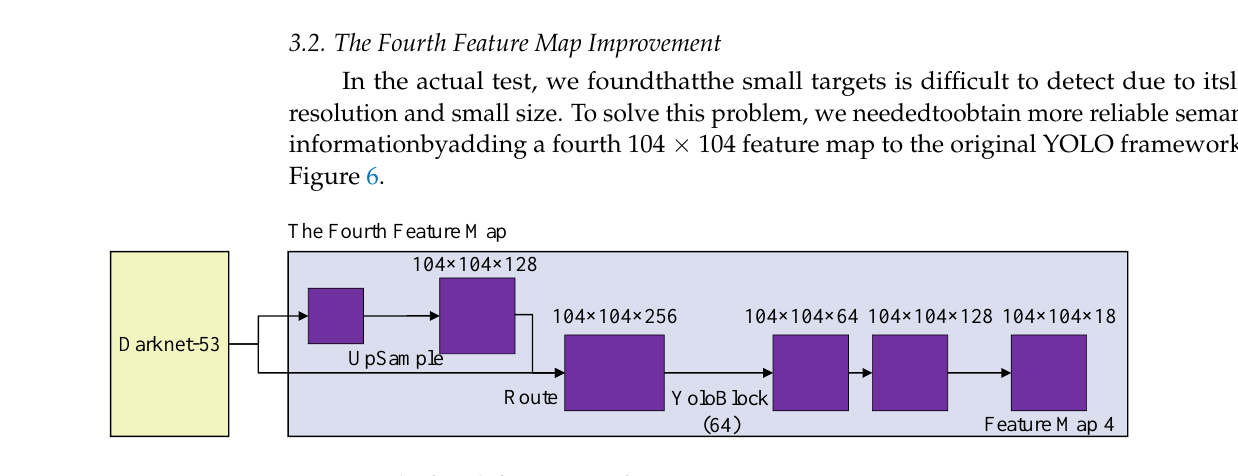
Figure 5. The detection process of original YOLOv3.( a )Original image,( b ) bounding boxes, ( c ) fi- nalresult.